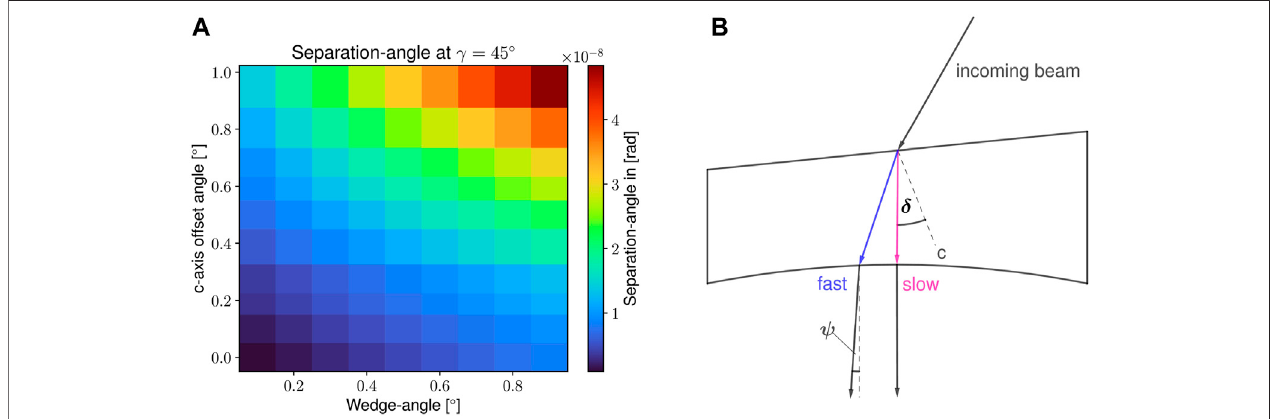
FIGURE10|(A) : distribution oftheseparation-angle ψ asafunction ofc-axis misalignmentand inputwedge-angle. (B) : sketchofawedgedITM(not toscale) with passing beam. The beam is split into a fast and a slow part whereas the slow part refracts perfectly in cavity-direction (curved surface) and the fast part exits with a separation-angle ψ